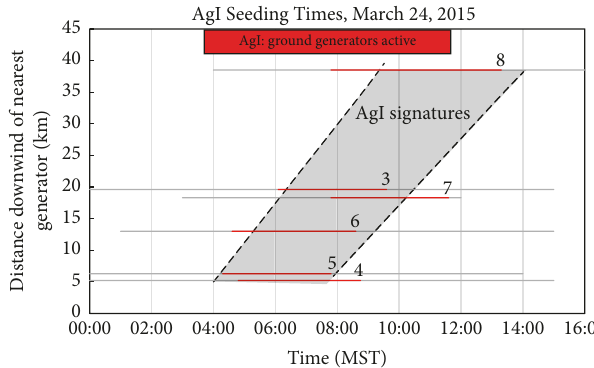
Figure 6: The time-delineation methods constrained the timing of Ag enrichments in snow for the Mar 24, 2015, storm (ground generator only). Red lines denote modeled times with replicated AgI signals. Grey lines denote portions of the snowstorm void of seeding signatures. Black numbers on plot are site IDs corresponding to Figure